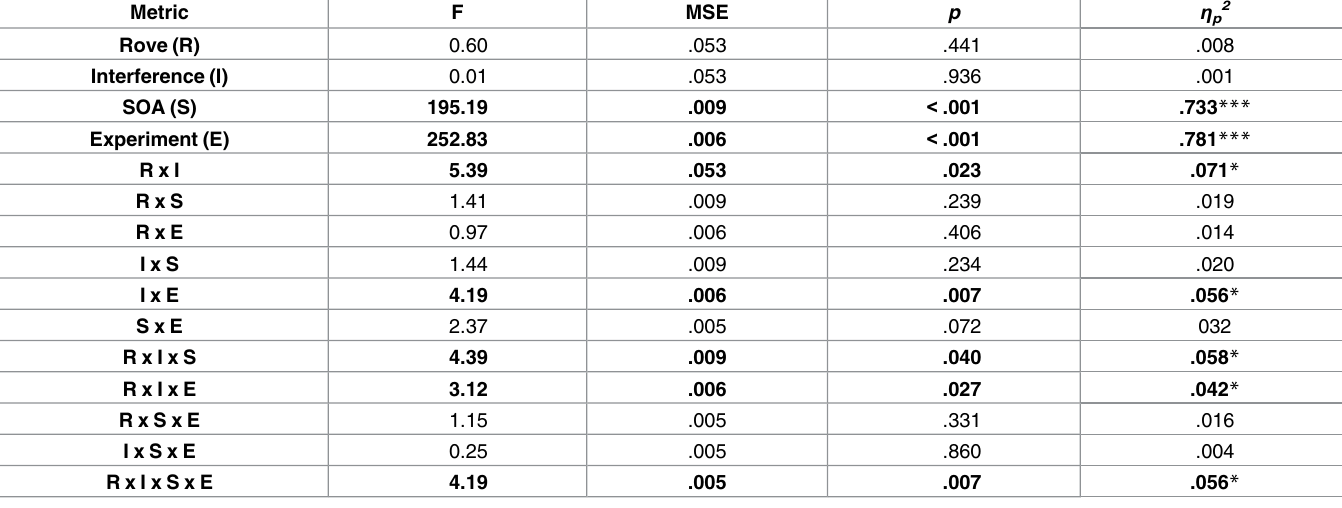
Table 2. Summaryof the four-way mixed model ANOVA comparing raw proportion correct data across Experiments 1–4 (all df s 1,71; apart from main effects and interactions with events [E] df s 3,213).